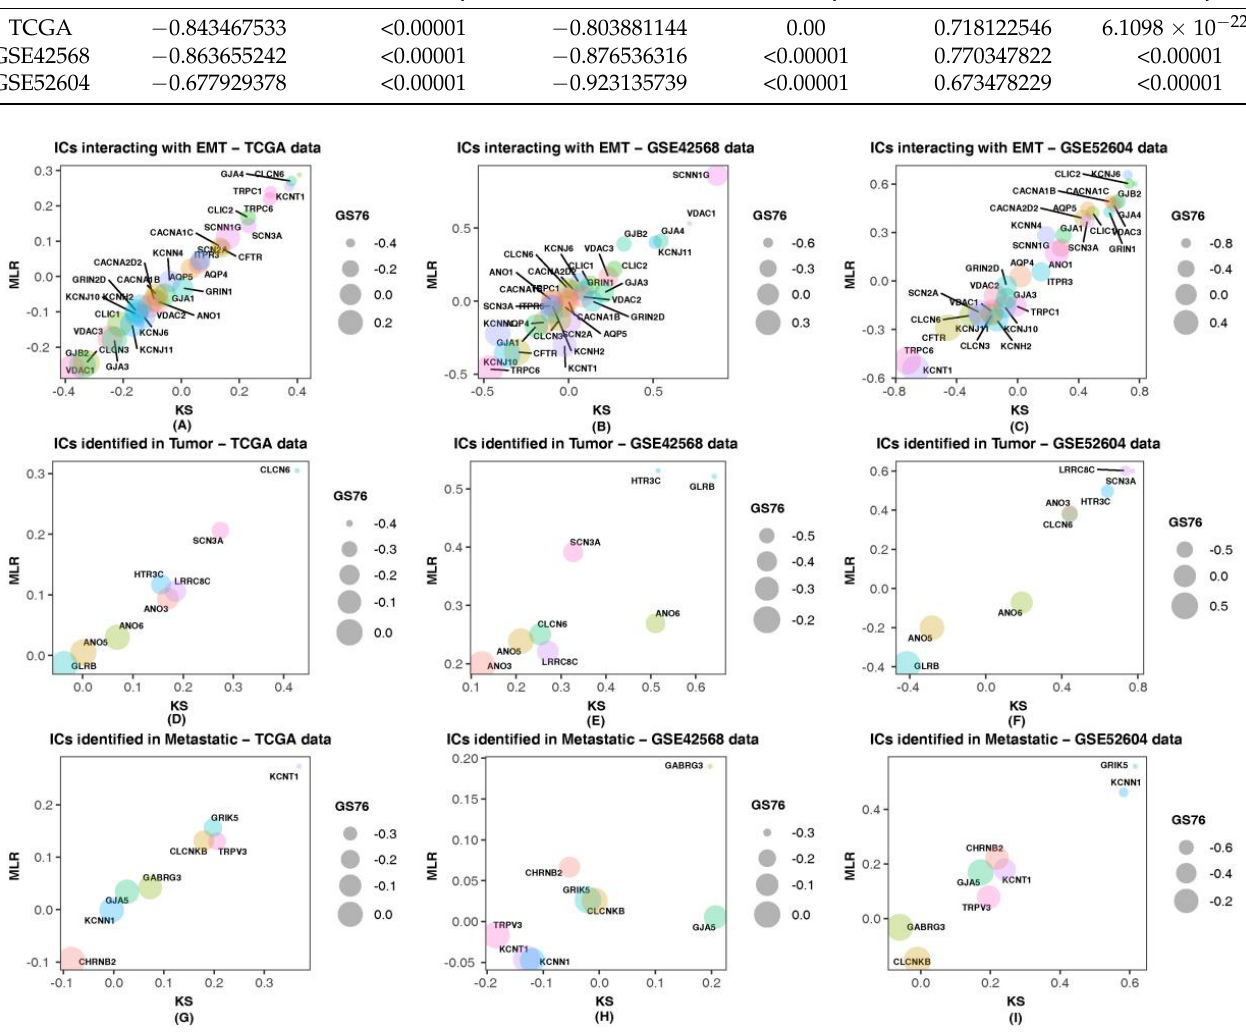
Figure 6. Correlation between ion channels (ICs) and EMT scores obtained using GS76, MLR and KS methods. In the bubble plot, the x-axis consists of correlation values of ion channels with the KS method, and the y-axis consists of correlation values with the MLR method. Each bubble corresponds to a particular ion channel represented by different colors. The size of the bubble corresponds to the correlation values of ion channels with GS76. TGCA data were used as RNA-Seq data and GSE42568 and GSE52604 were microarray datasets. ( A – C ) Correlation of ICs identified as interacting with EMT-related genes with GS76, MLR and KS scores; ( D – F ) Correlation of ICs identified in tumor state with GS76, MLR and KS scores; ( G – I ) Correlation of ICs identified in metastatic state with GS76, MLR and KS